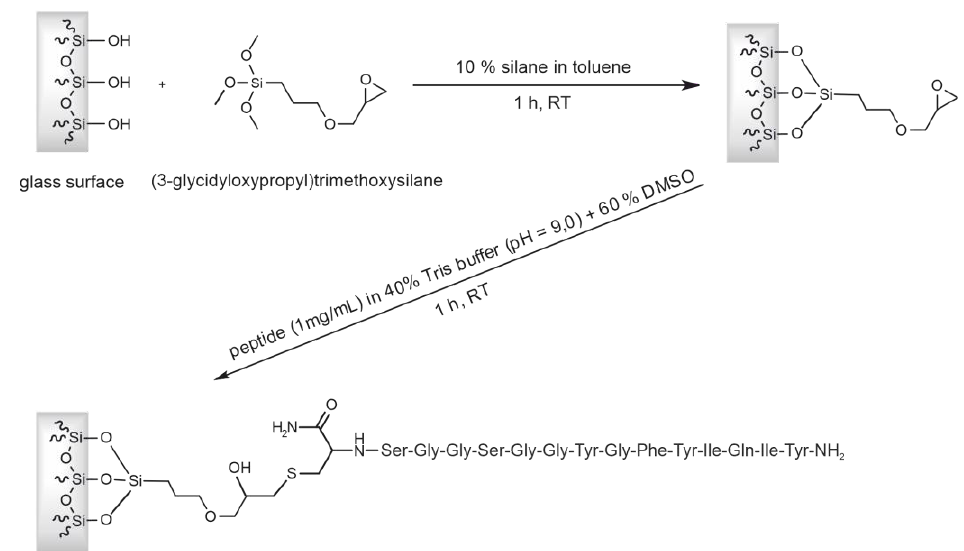
Figure 5. Scheme for preparing the affinity column for CCMV purification: Surface functionalization of a sintered glass monolith with epoxy silane and coupling of the thiol-containing CCMV-binding peptide aptamer via ring-opening of the epoxide. Please note: In this figure, the N -terminus of the peptide NH 2 -Tyr-Ile-Gln-Ile-Tyr-Phe-Gly-Tyr-Gly-Gly-Ser-Gly-Gly-Ser-Cys-NH 2 is located on the right-hand side, and the C -terminus is amidated. Due to the specific synthesis and subsequent screening procedure, the peptide must be oriented so that the C-terminus is directed toward the solid phase.